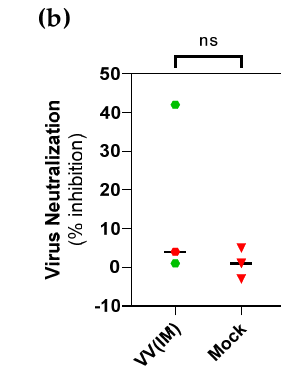
Figure 4. Anti-OvHV-2 antibody response in plasma of animals that developed MCF or were protected from disease following immunization with the AlHV-1-vectored vaccine delivered by intramuscular injection [VV(IM)] or a mock control and challenge with OvHV-2 in Experiment 2. ( a ) Individual OD ratio in plasma diluted at 1:400, as detected by ELISA. ( b ) Neutralizing antibody response at challenge time (64 days post-prime immunization), as measured by viral neutralization assay. Arrows represent immunizations (green) and challenge (red) times. ns, not statistically